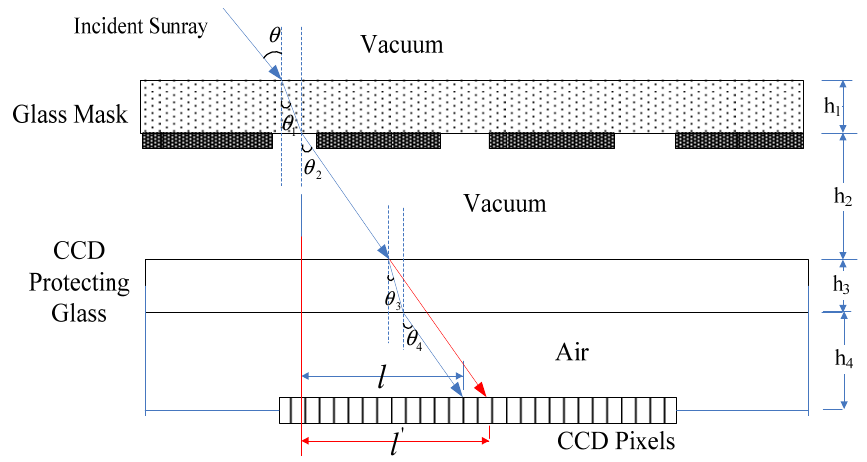
Figure 5. Illustration of the refraction